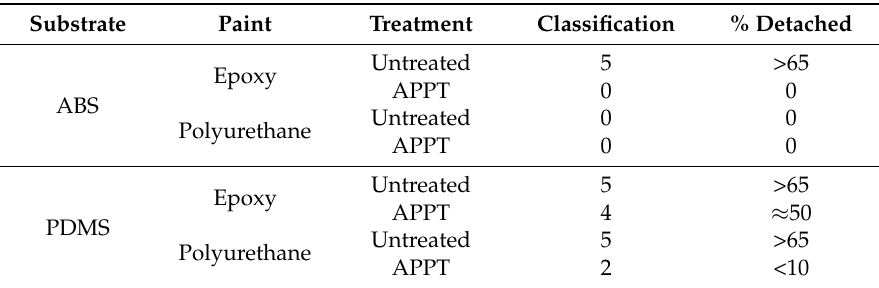
Figure 8. SEM micrographs of the cross-cut test of treated PDMS with polyurethane ( a ) PDMS +